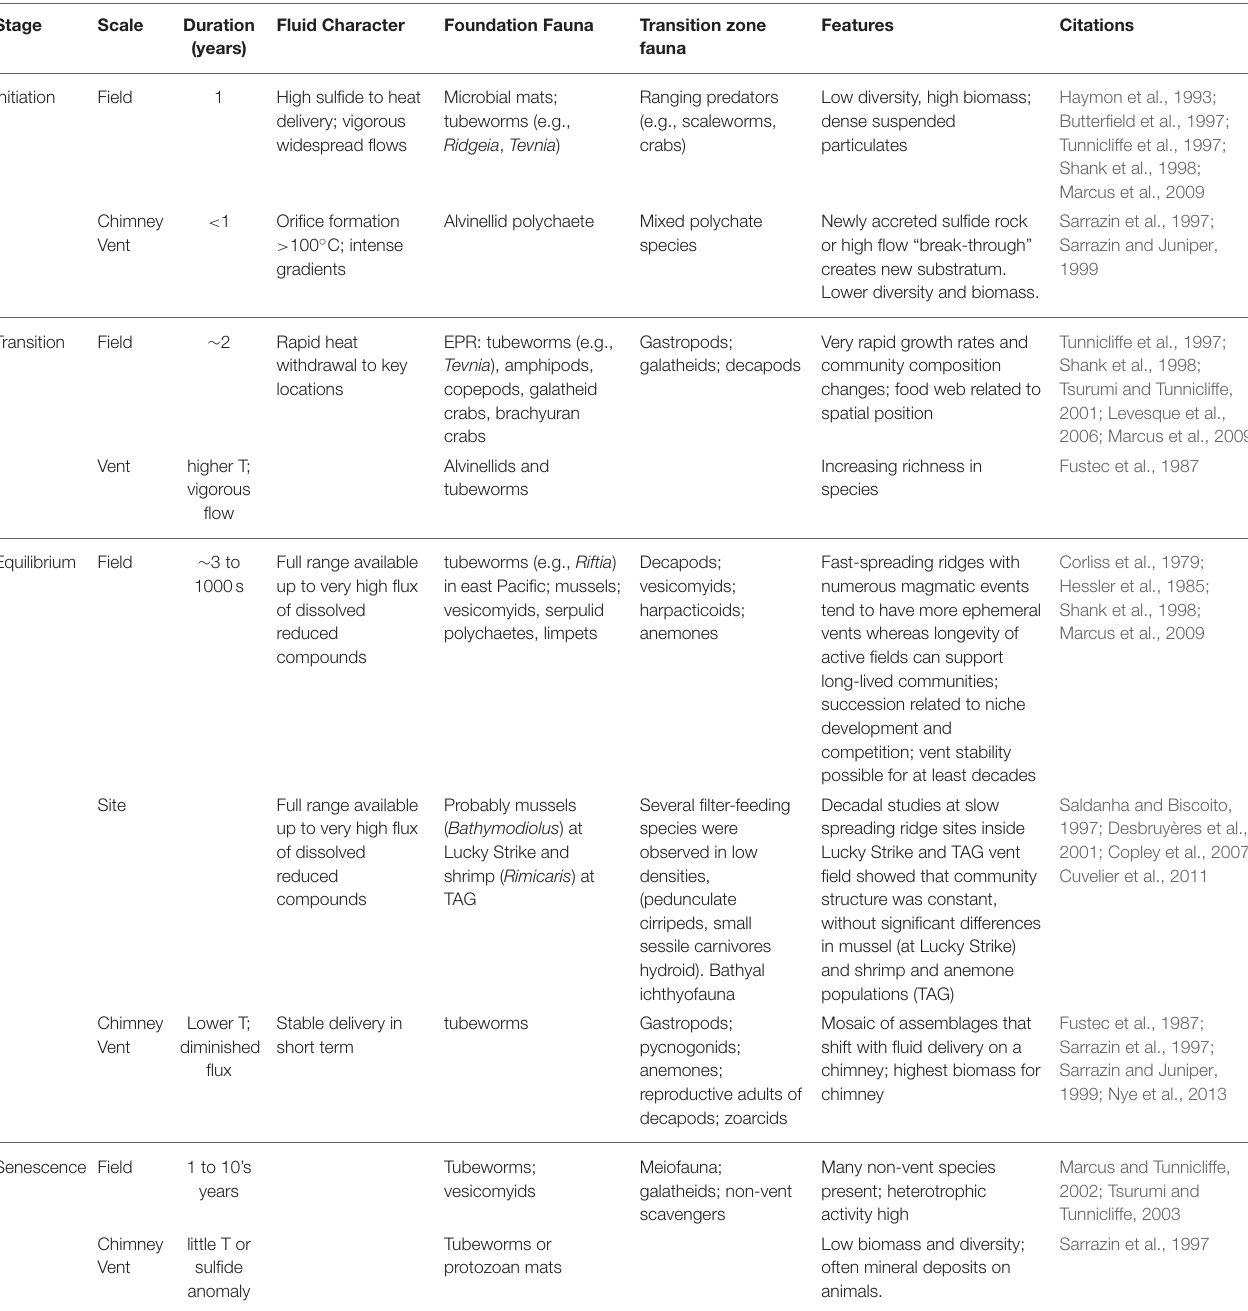
TABLE 2 | Temporal succession at hydrothermal